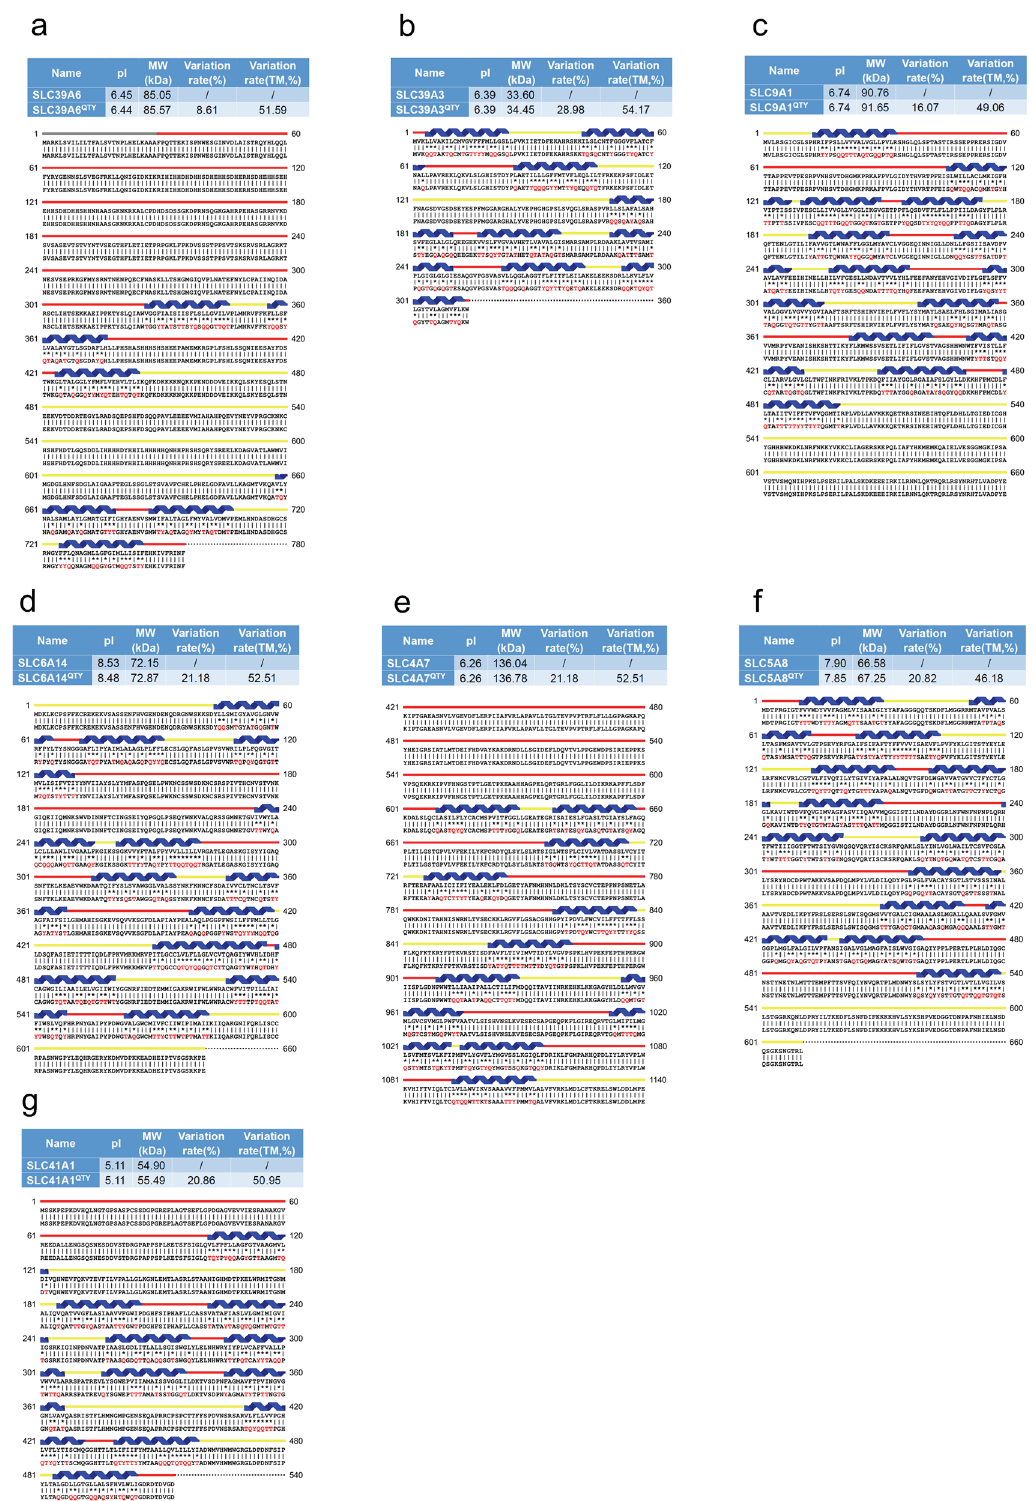
Figure 2. Protein alignment of eight native solute carrier transporters with their water-soluble QTY variants. All characteristics and color codes are referred in Fig. 1. The alignments are: ( a ) SLC39A6 versus SLC39A6 QTY , ( b ) SLC39A3 versus SLC39A3 QTY , ( c ) SLC9A1 versus SLC9A1 QTY , ( d ) SLC6A14 versus SLC6A14 QTY , ( e ) SLC4A7 versus SLC4A7 QTY , ( f ) SLC5A8 versus SLC5A8 QTY , ( g ) SLC41A1 versus SLC41A1 QTY (see Tables 2,